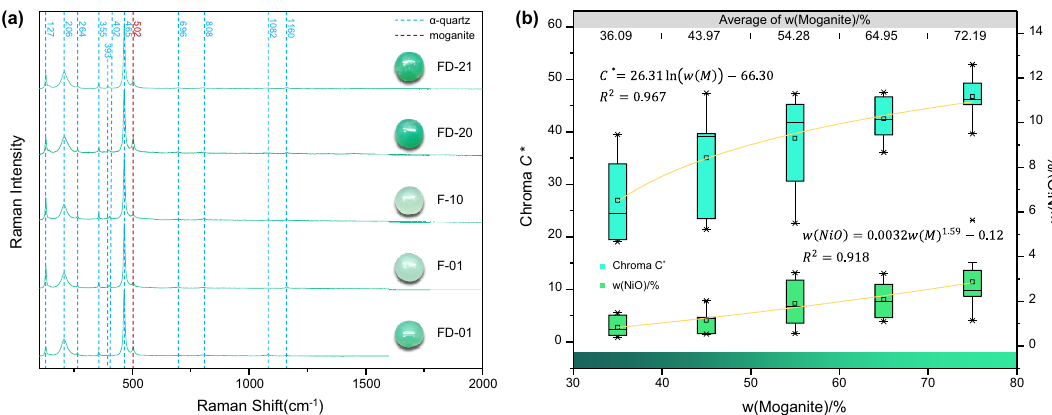
Figure 5. Raman spectra of chrysoprase. ( a ) All samples show standard Raman peaks of α-quartz and the characteristic peak of moganite of 502 cm −1 . ( b ) Relationship between w(Moganite) and chroma and w(NiO). The chroma and Ni content of chrysoprase both increase with increasing moganite